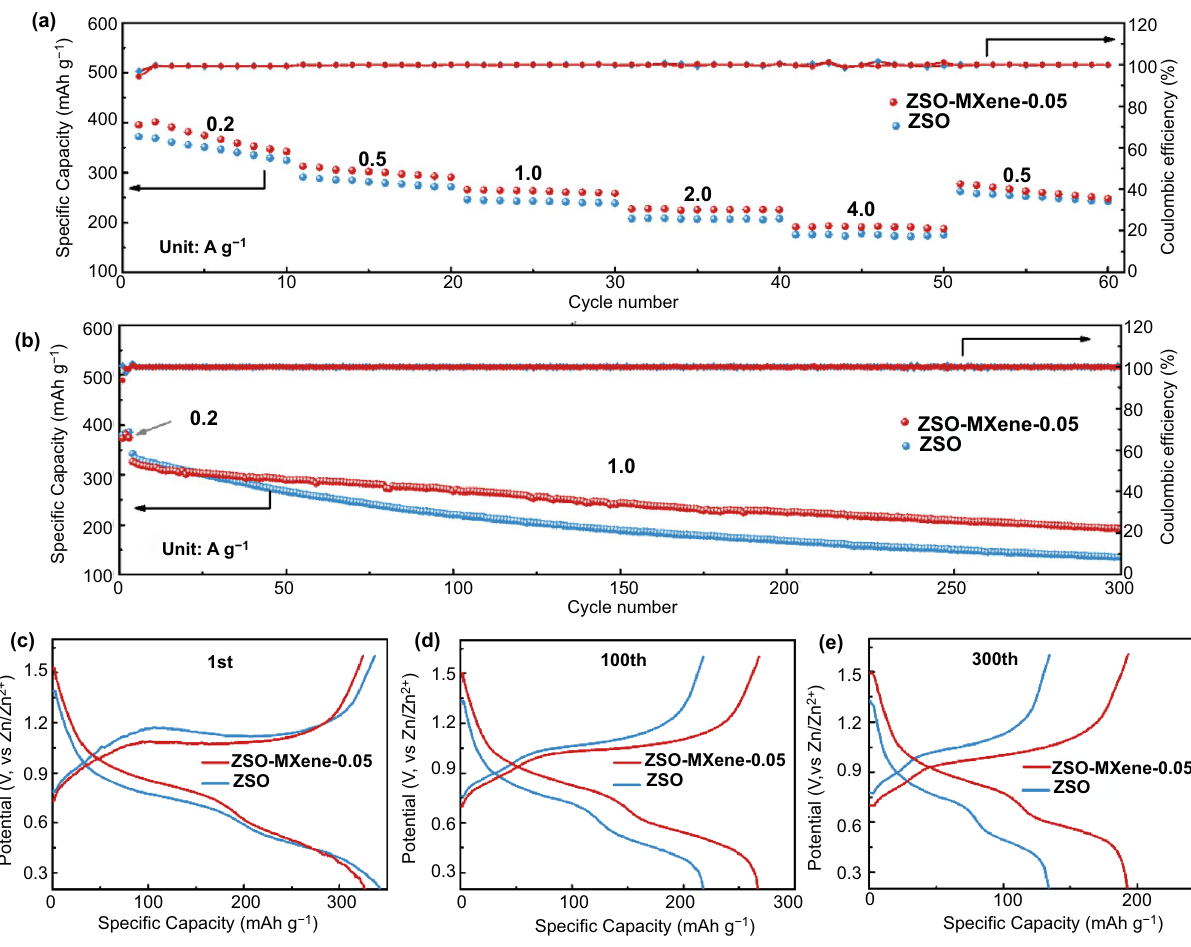
Fig. 5 Electrochemical performance of full cells with and without MXene additive a Rate performance of Zn-V 2 O 5 full cells from 0.2 to 4 A g −1 . b Long-term cycling performance of Zn-V 2 O 5 full cells. Voltage profiles of Zn-V 2 O 5 full cells at current density of 1 A g −1 for the c 1st, d 100th and e 300th